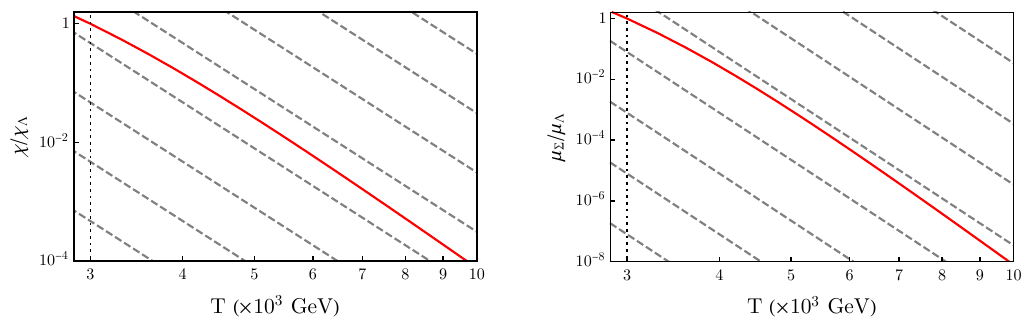
Figure 4 . Topological susceptibility in the DGA for N F = 3 and (cid:3) = 3 TeV con(cid:12)nement scale. The dashed gray lines are plotted for reference only, and have slope T (cid:0) 8 (left) and T (cid:0) 16 (right).